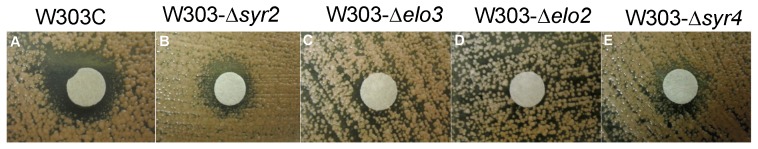
Disk-diffusion antifungal assays of FG08 against S. cerevisiae W303C and sphingolipid biosynthetic mutants.Ten µL aliquots of 1 mg mL−1 solutions of FG08 were applied to paper disks placed on YPD medium agar surfaces spread-plated with YPD medium-grown cells of S. cerevisiae strain W303C (A), W303-Δsyr2 (sur2) (B), W303-Δelo3 (C), W303-Δelo2 (D) and W303-Δsyr4 (itp1) (E). The plates were incubated for 48 h at 28°C.